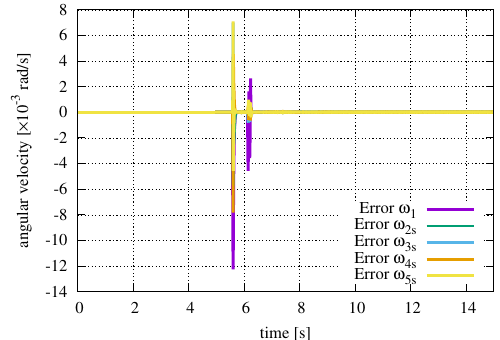
Figure 12. Case 1: Time variation of estimation error of the angular